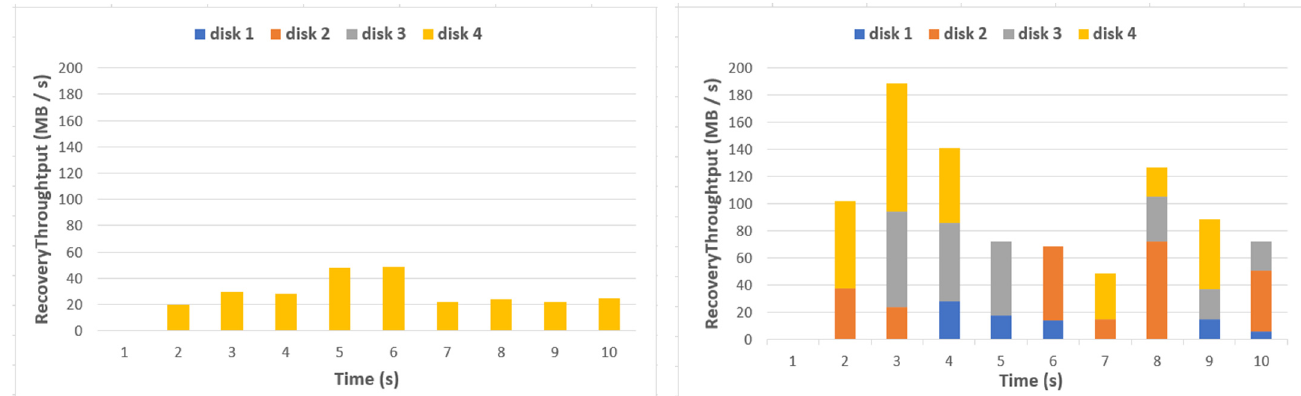
Figure 6. Disk usage in DataNode 1 during multithread fault recovery.